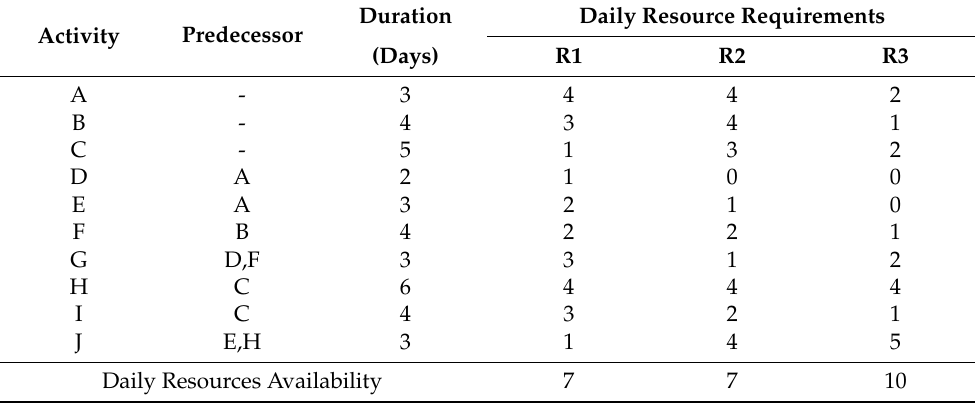
Figure 2. Network diagram for project A.